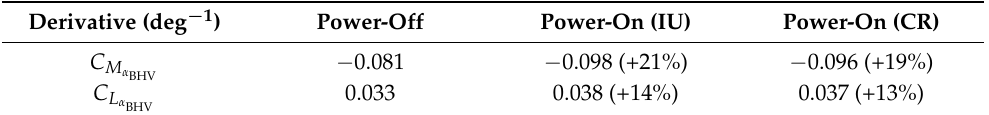
Table 9. Effect of propeller rotation on overall (direct + indirect) propulsive effects on lift and pitching moment coefficient curve slope, BHV aircraft configuration, experimental results, Re = 315,000, RPM 8750, X CG at LE